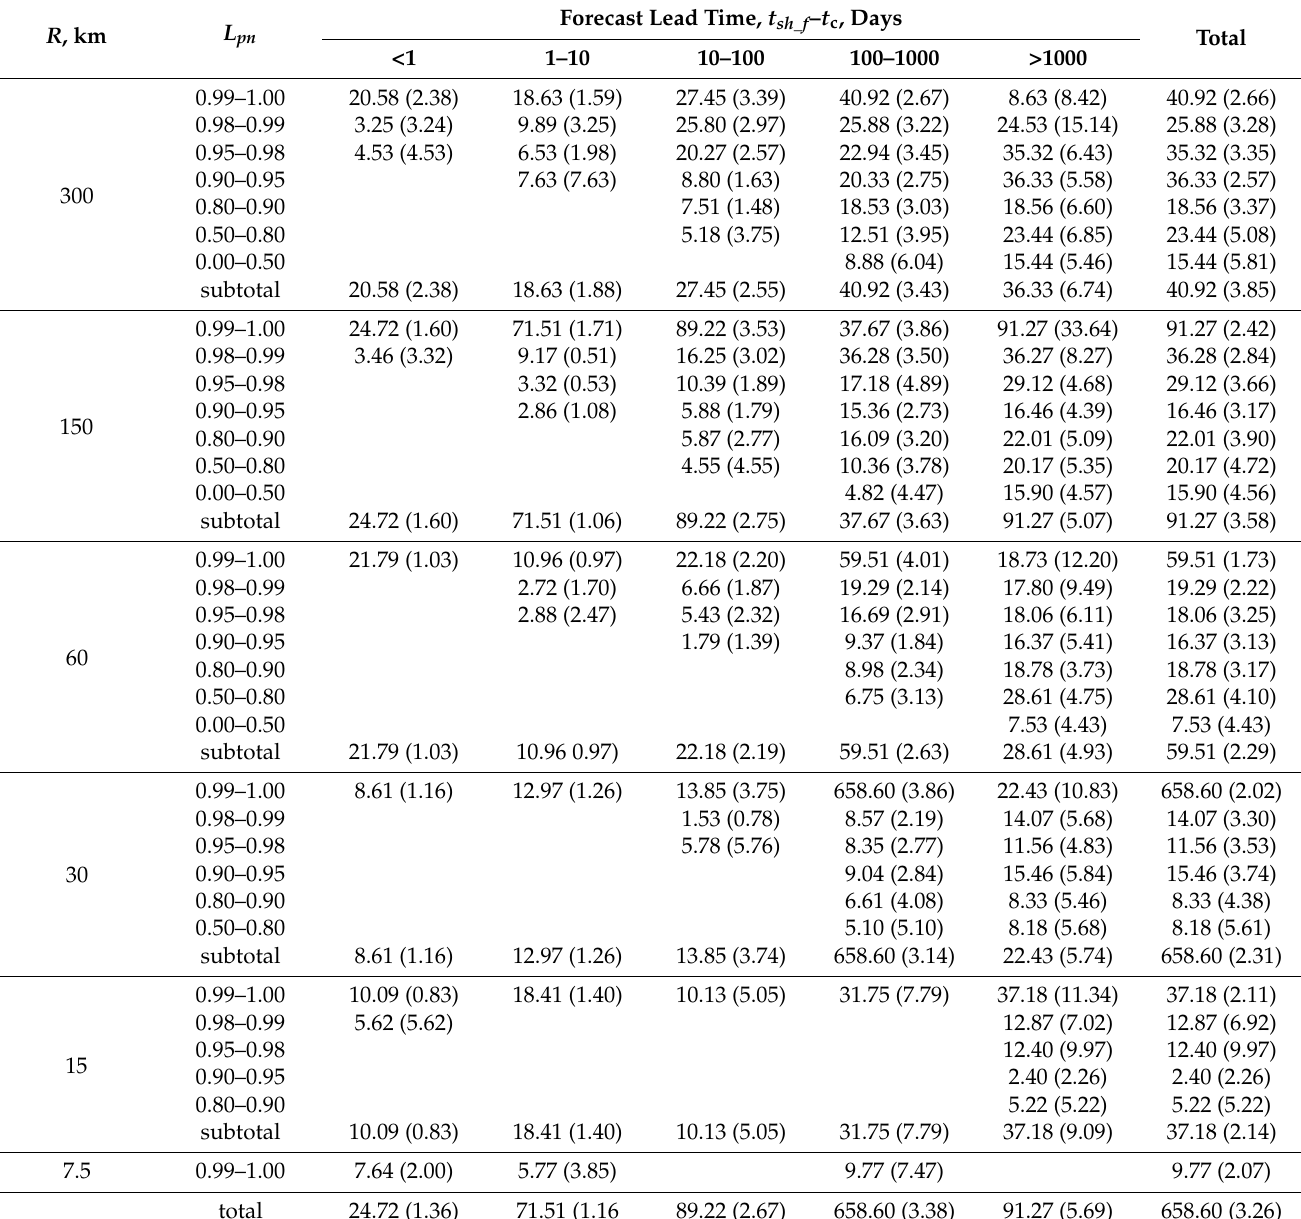
Table A3. The maximum (average) relative accuracy ∆ of foreshock retro-forecasts depending on the sample radius R , predictive nonlinearity L pn and forecast lead